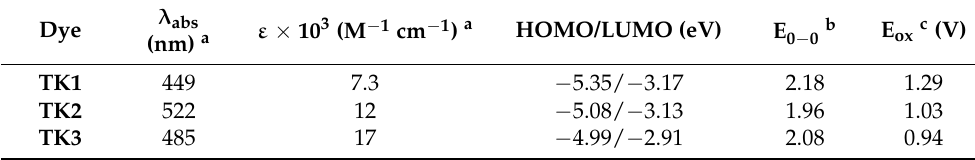
Table 5. Absorption and electrochemical data of TK1 , TK2 and TK3 .